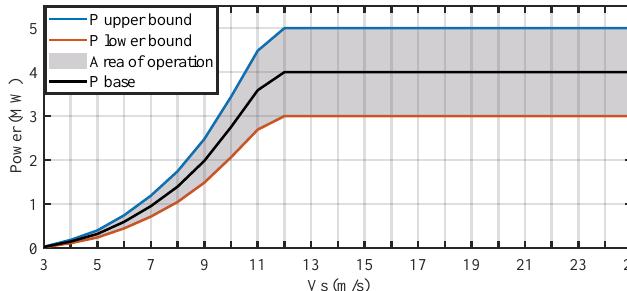
Figure 5. Control design for 20% FCR.